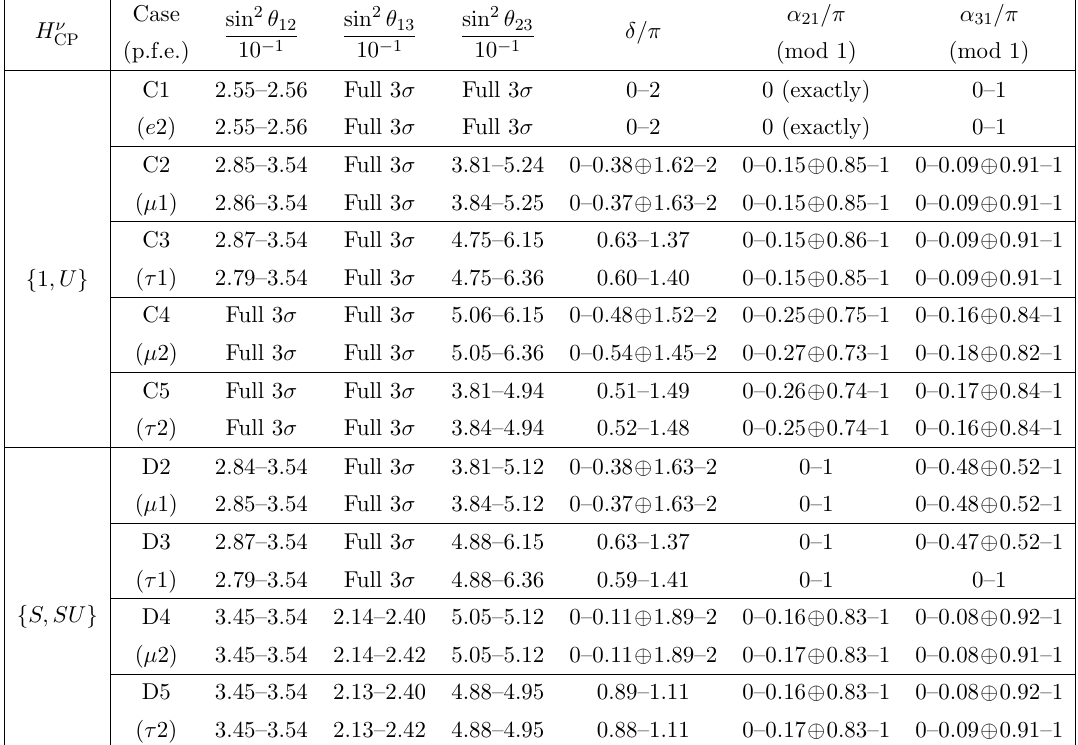
Table 4 . The same as in table 3, but for G e = Z g e In this case the magnitude of the (cid:12)xed element is 1 =